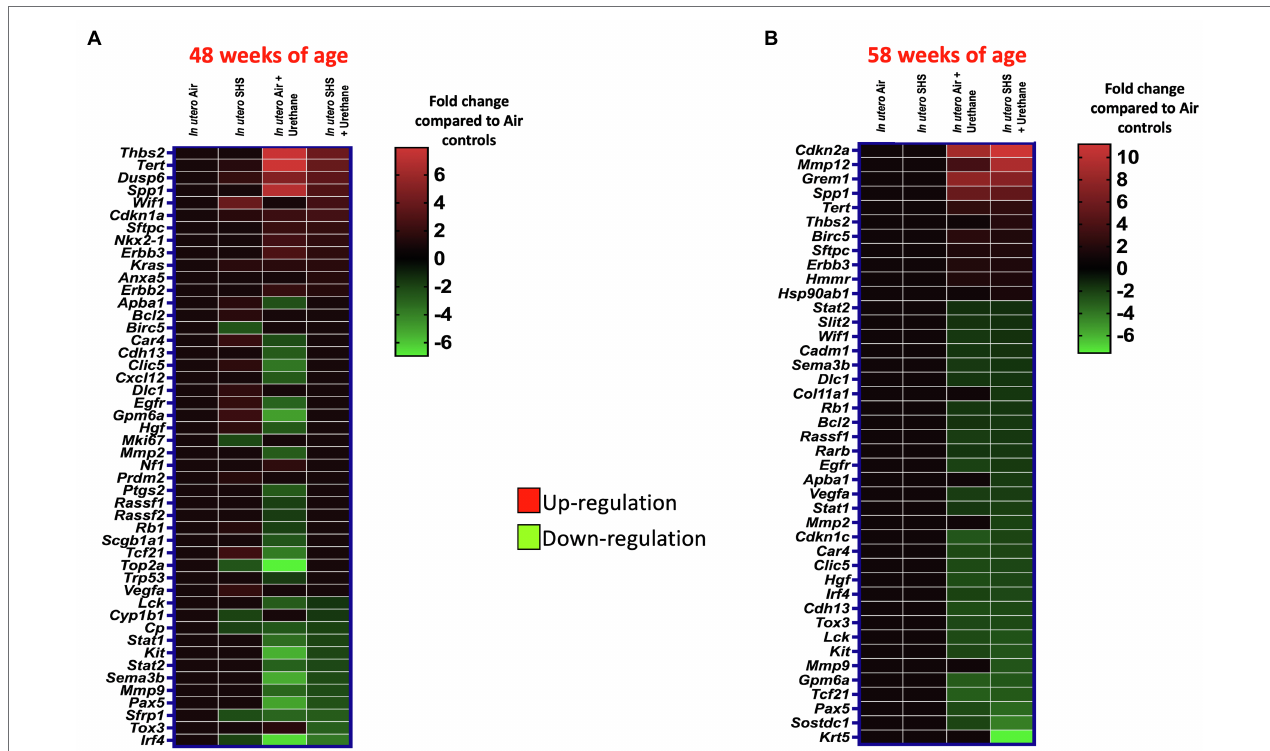
FIGURE 13 | In utero SHS plus adult urethane dysregulated the expression of lung genes involved in matrix remodeling and metastasis propagation at 58 weeks. (A,B) Heatmaps display gene expression data obtained by RT2-PCR array from the lungs of 48- and 58-week-old female mouse offspring, respectively. N = 4 per group. Data are expressed as mean per group. Genes displayed have fold-changes > ±1.5 up-/down-regulation compared to the in utero air plus saline control group and were considered